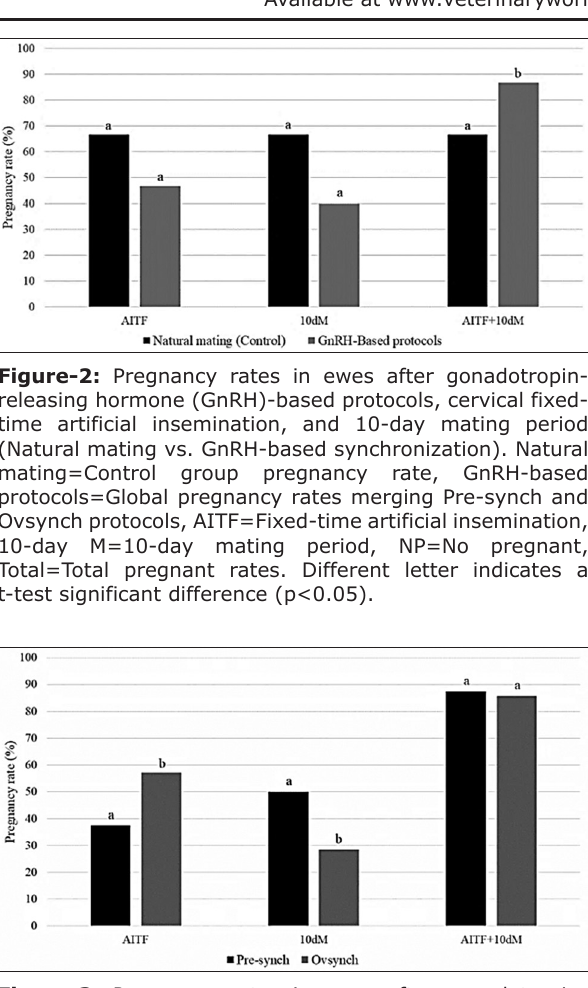
Figure-3: Pregnancy rates in ewes after gonadotropin- releasing hormone (GnRH)-based protocols, cervical fixed-time artificial insemination, and 10-day mating period. (Pre-synch vs. Ovsynch). AITF=Cervical time-fixed artificial insemination; 10-day M=10-day mating period; NP=No pregnant; Total=Total pregnant rates. Different letter indicates a t-test significant difference (p<0.05).